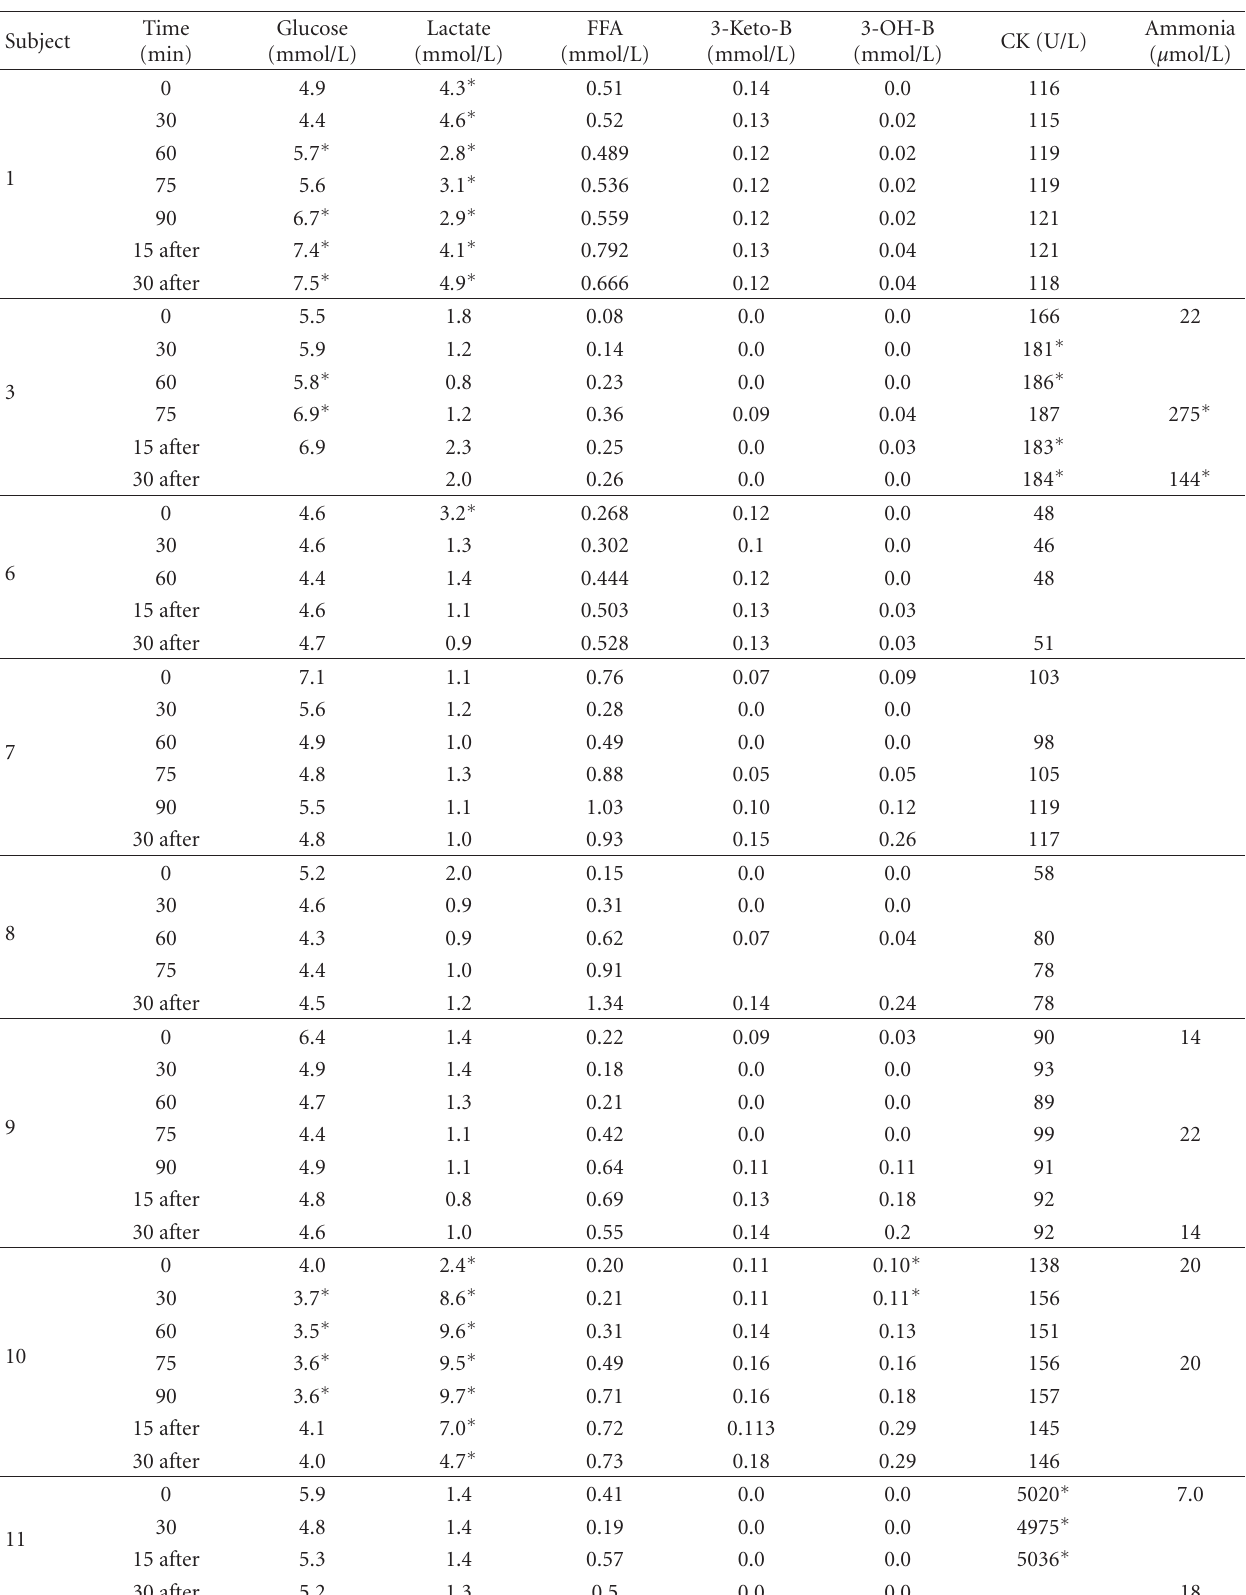
Table 3: Biochemical measurements of patients during the PXT